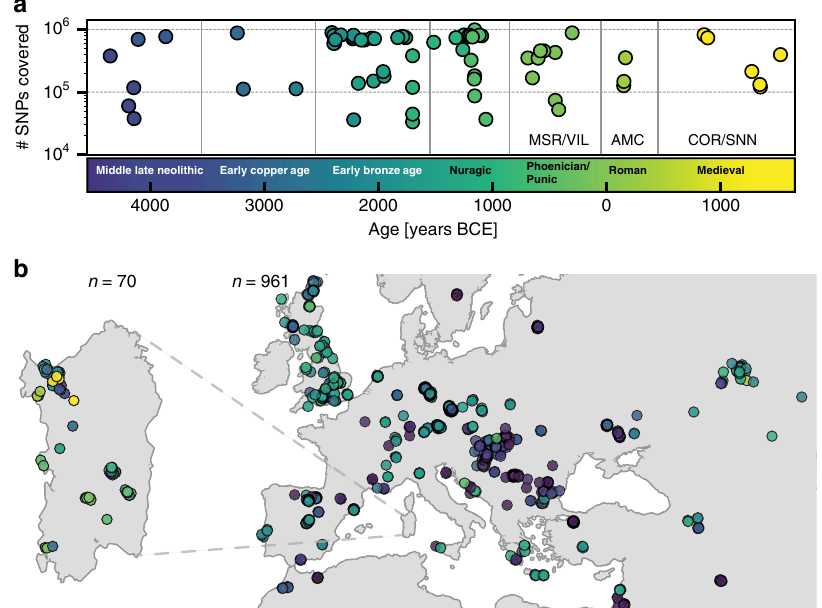
Fig. 1 Number of SNPs covered, sampling locations and ages of ancient individuals. a The number of SNPs covered at least once and age (mean of 2 σ radiocarbon age estimates) for the 70 ancient Sardinian individuals. b The sampling locations of ancient Sardinian individuals and a reference dataset of 961 ancient individuals from across western Eurasia and North Africa (with “ jitter ” added to prevent overplotting; see Supp Data 1E for exact